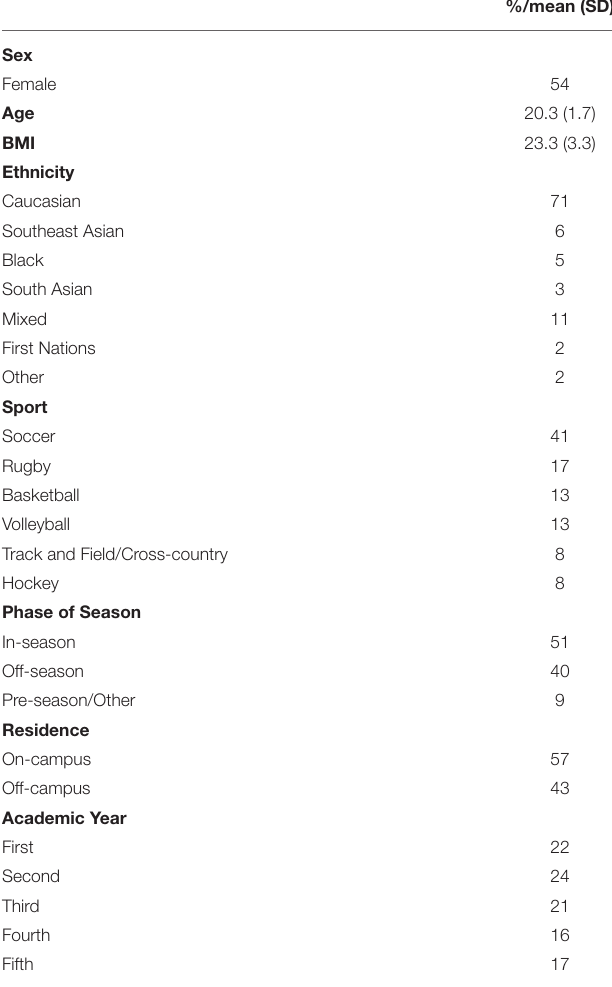
TABLE 1 | Sociodemographics ( n =